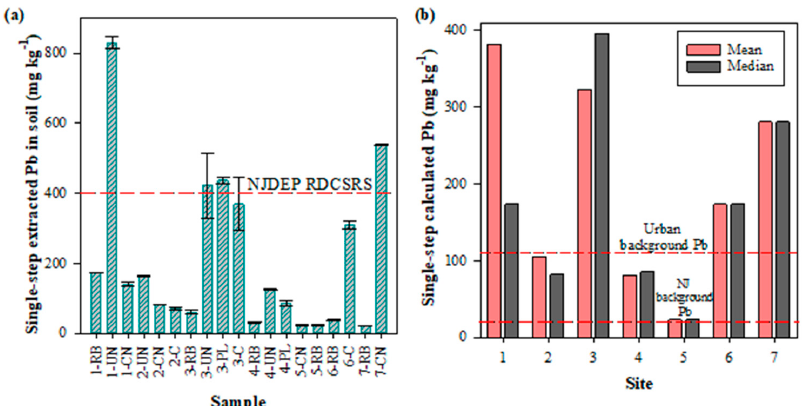
Figure 2. Single-step 1 M HNO 3 extracted Pb for ( a ) all samples referenced to the New Jersey Department of Environmental Protection (NJDEP) Residential Direct Contact Soil Remediation Standard (RDCSRS) (400 mg kg − 1 ); ( b ) the calculated mean and median of all categories for each site referenced to the background Pb in New Jersey (22 mg kg − 1 ) and urban background Pb (111 mg kg − 1 ).